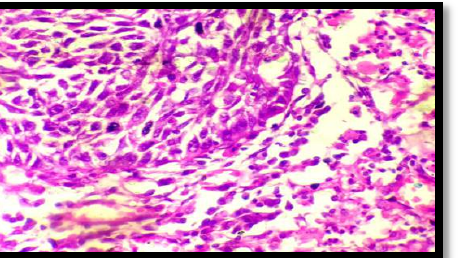
Figure 4: (x200): Histological section showed intense stromal eosinophilia in conventional squamous cell